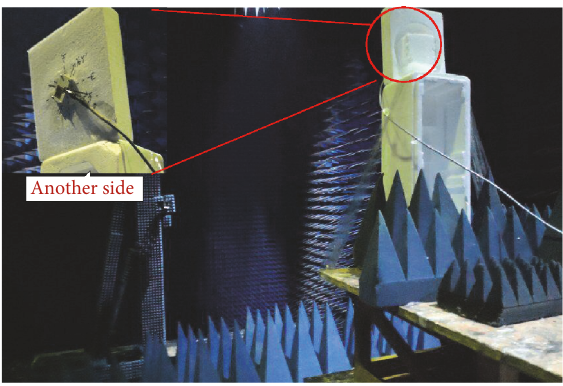
Figure 11: Measured environment of proposed antenna.